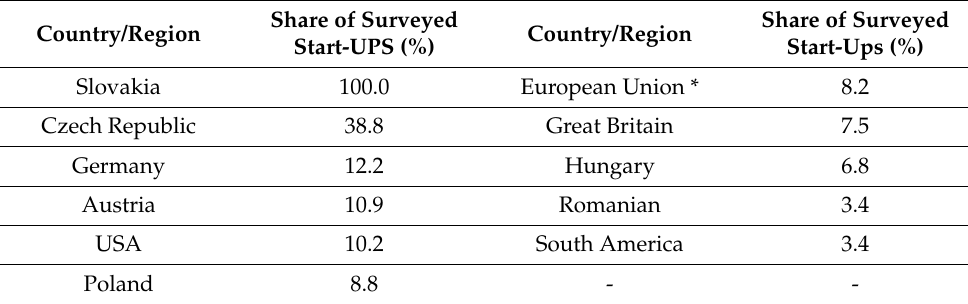
Table 1. Geographical localization of the markets of the examined start-ups. Share of Surveyed Share of Surveyed Country/Region Country/Region Start-Ups (%) Start-UPS (%) Slovakia 100.0 European Union * 8.2 38.8 Great Britain 7.5 12.2 6.8 10.9